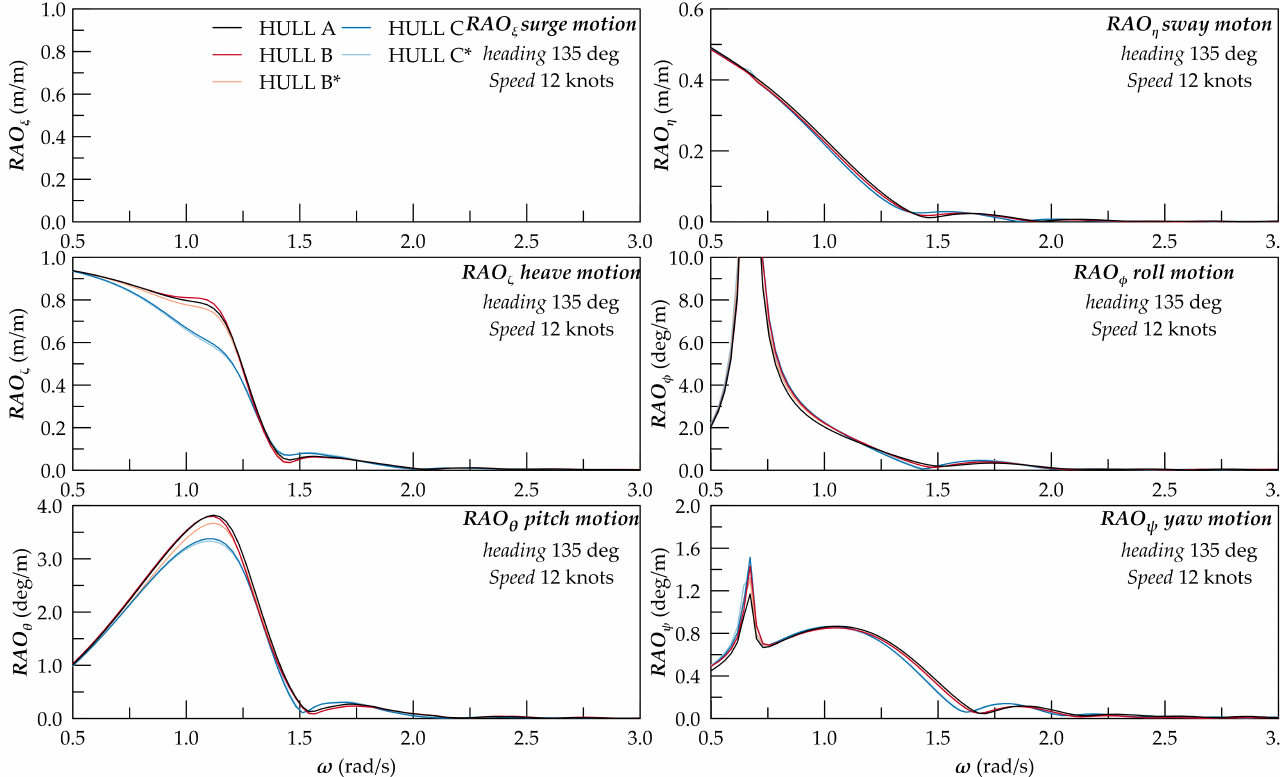
Figure 11. Six DOF RAOs at 12 knots on the reference hulls for the AWI heading of 135